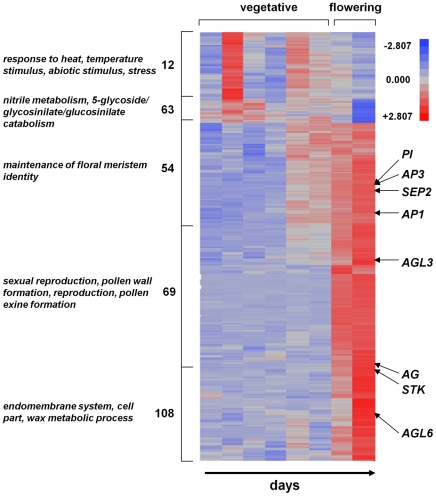
Heat map for Bay-0 genes that show differential expression during flowering.The numbers listed to the left indicate the cluster number identified in the silhouette analyses. The four most significant (i.e., lowest p values) GO term categories enriched for each cluster are shown on the left. The vegetative and flowering samples are indicated at the top, and the rows corresponding to various flower development genes are shown. Several developmental genes associated with bolting and flower development are highlighted. Scale: from brightest blue equals most down-regulated to brightest red equals most up-regulated.